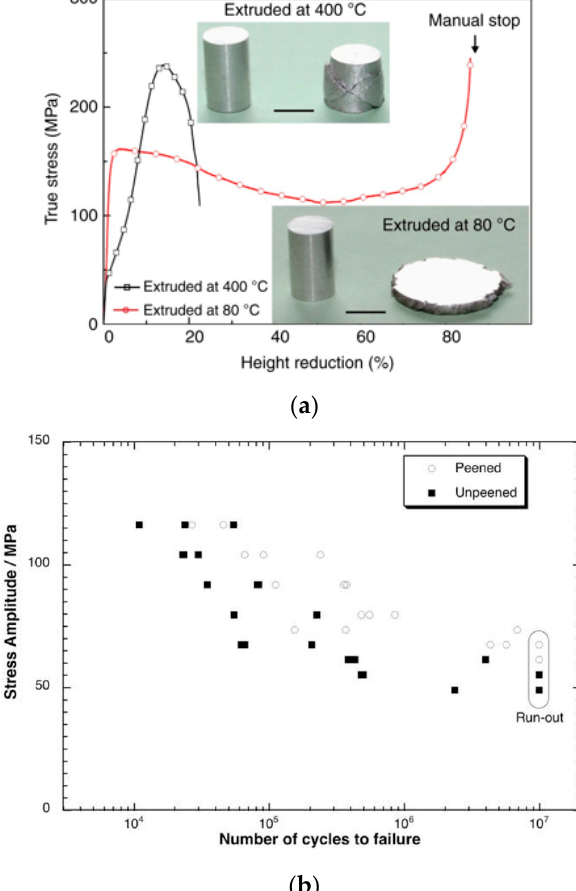
Figure 8. ( a ) Room temperature compression of specimens extruded at 80 and 400 °C with speci- mens before and after compression test [70]; ( b ) Stress amplitude versus number of cycles to fail- ure for the peened and unpeened samples